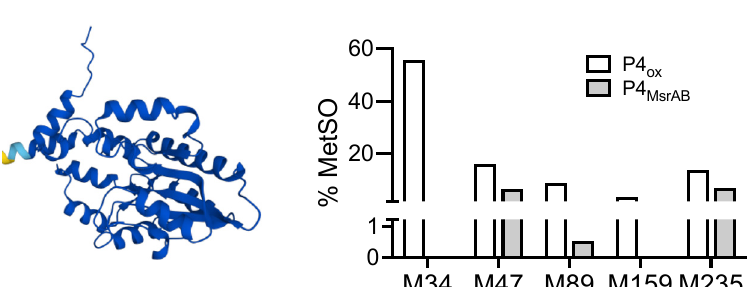
Figure 4. H. influenzae rMsrAB can repair oxidative damage to lipoprotein eP4. ( Top ): Amino acid sequence of lipoprotein eP4: bold—methionine residues with amino acid number in sequence; underlined—methionine containing peptides; grey font—eP4 lipoprotein signal peptide, not part of the expression construct. ( Bottom left ): Structural representation of eP4, based on Alphafold database structural model. ( Bottom right ): Methionine oxidation in oxidised P4 protein samples and following repair of oxidative damage with rMsrAB. M ‐ Methionine.